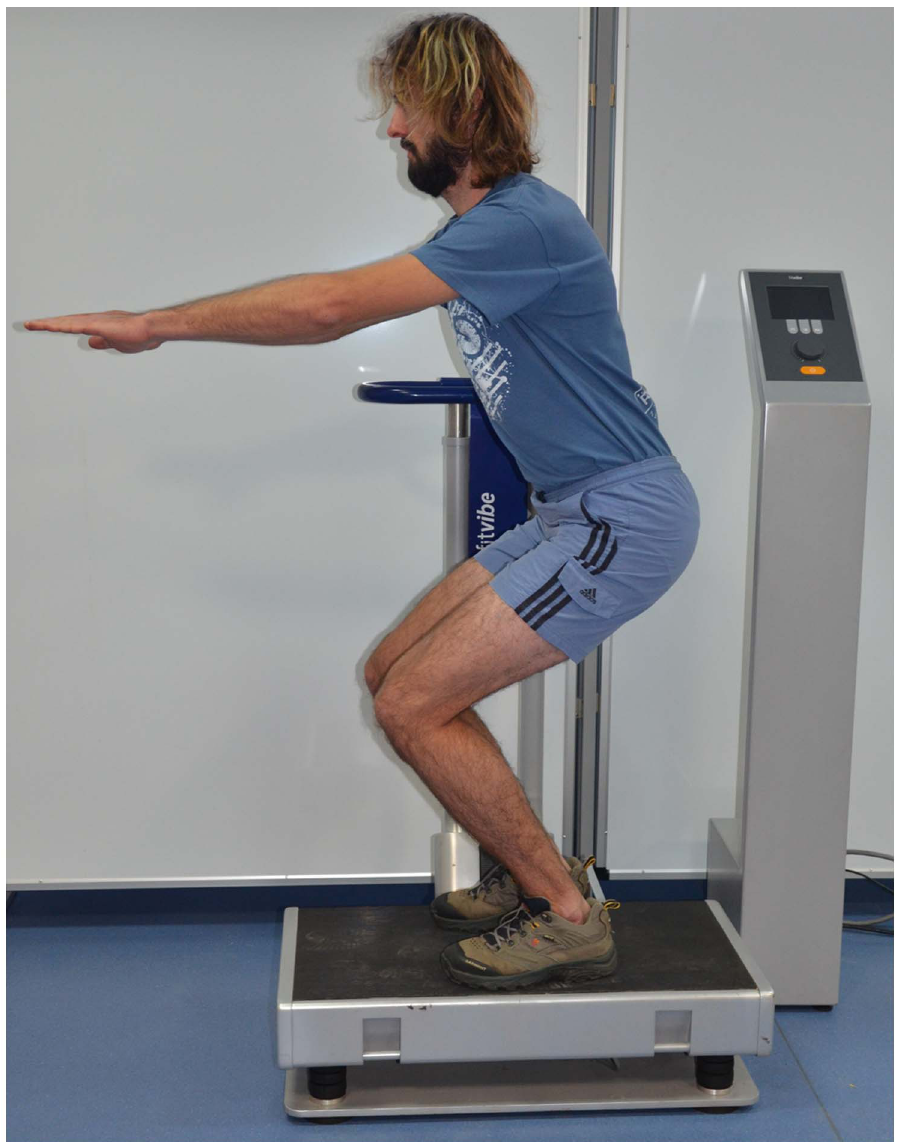
Figure 2. Whole-body vibration.